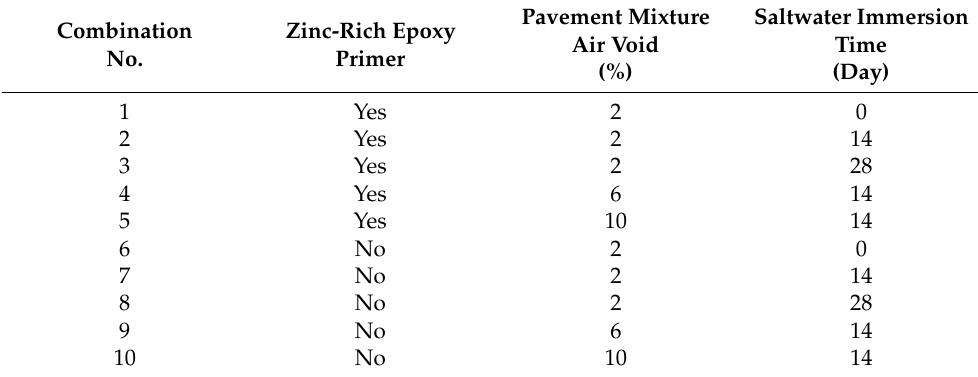
Table 8. Combinations of test parameters for pavement composite structure 1 .